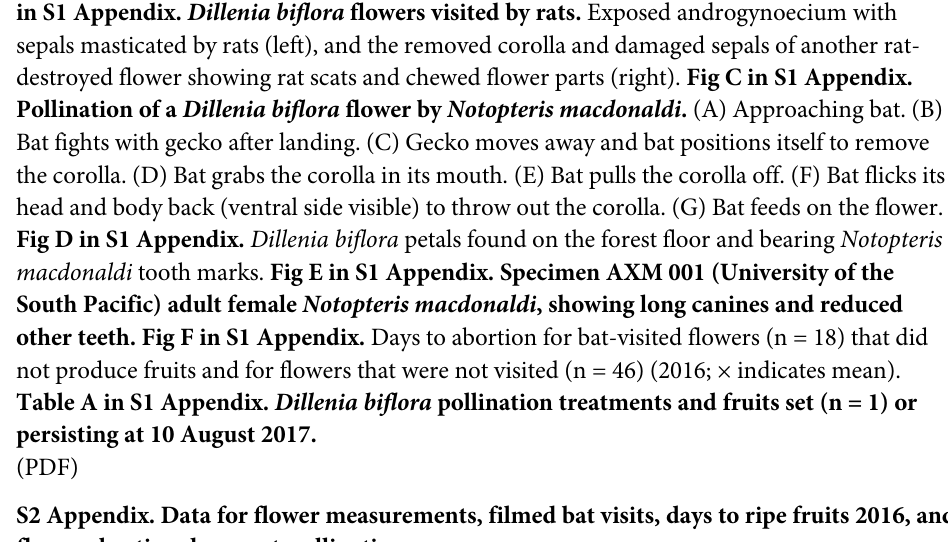
Table A in S1 Appendix. Dillenia biflora pollination treatments and fruits set (n = 1) or persisting at 10 August